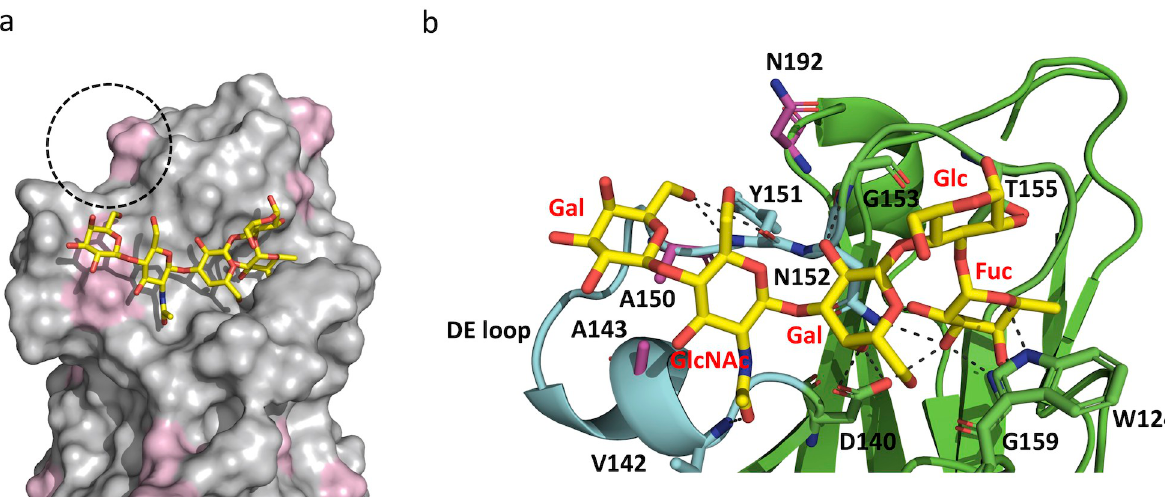
Fig 8. MD-derived structure of lacto-N-fucopentose VI bound to UcaD LD . A representative minimum-energy conformation of the glycan (yellow) shown in stick representation. a) Surface representation of UcaD LD . UcaD LD /UclD LD variable residues are highlighted in purple. The dashed circle highlights a potential binding site for the sialic acid residue of sialyllacto-N-fucopentose VI, which binds to UclD LD with high affinity. b) Cartoon representation of UcaD LD with the DE loop highlighted in cyan. Lacto-N-fucopentose VI -interacting residues and UcaD/UclD variable residues (purple) are shown in stick representation. In this model, the glycan is stabilised by polar interactions with the side-chains of D140 (internal Gal C4’ hydroxyl) and T155 (Glc C2’ hydroxyl), and the backbone of Y151 (terminal Gal C6’ hydroxyl), V142 (GlcNAc amine group) and G153 (internal Gal C2’